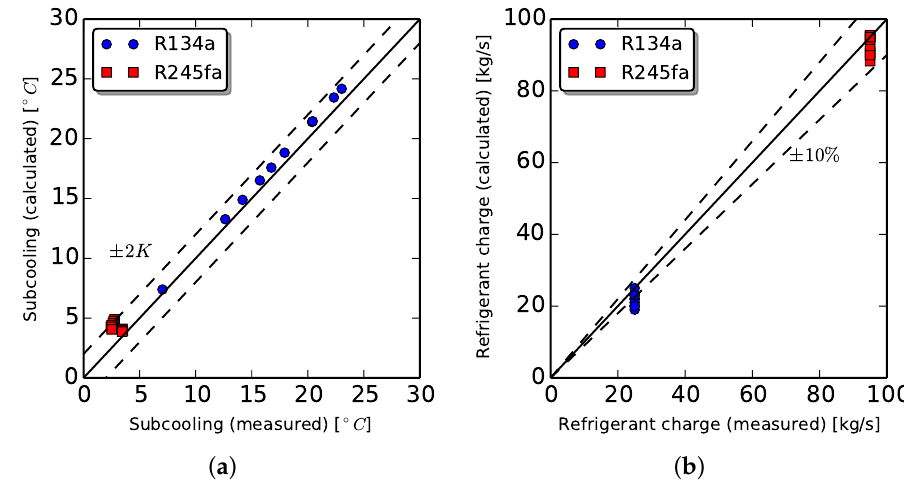
Figure 14. Parity plots of predicted and measured values of subcooling and refrigerant charge using charge-based solver and subcooling based-solver, respectively. Both ORC systems are included in each parity plot. The total refrigerant charge considered for the validation is 95 kg for the ORC at Ghent University and 25 kg for the ORC at Herrick Laboratories, Purdue University. ( a ) Imposed refrigerant charge; ( b ) Imposed